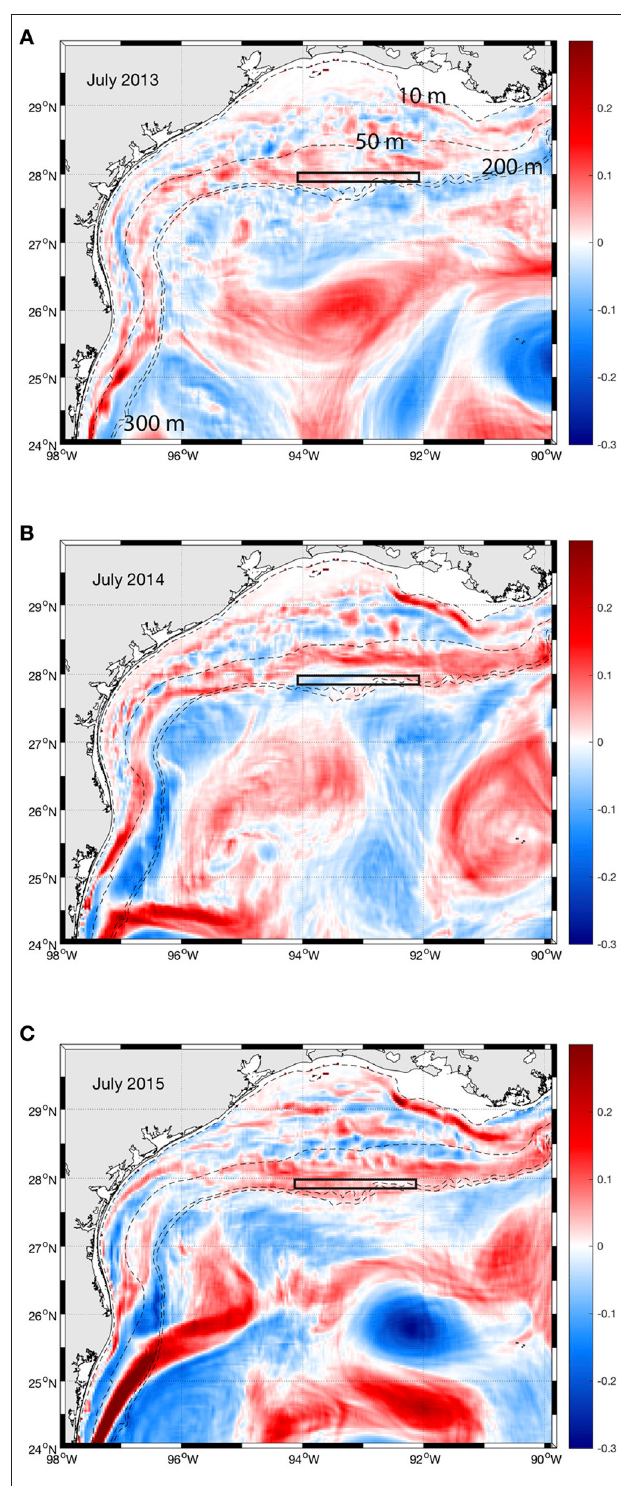
FIGURE 6 | Monthly mean normalized relative vorticity ( ζ/ f ) at 10m in the northwest Gulf of Mexico. ζ is the curl of the velocity and f is the Coriolis parameter. Numbers show the isobaths depth. (A) July 2013. (B) July 2014. (C) July 2015. The black rectangle shows the location of the banks (West FGB, East FGB, Bright, Geyer, Mc